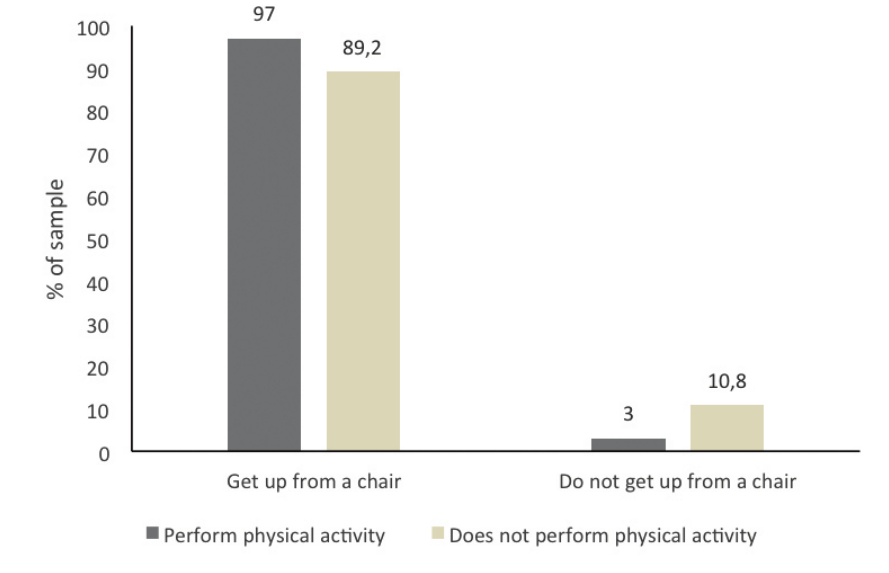
Figure 2 - Association between self-perception of health and the functional ability of rising from a chair.